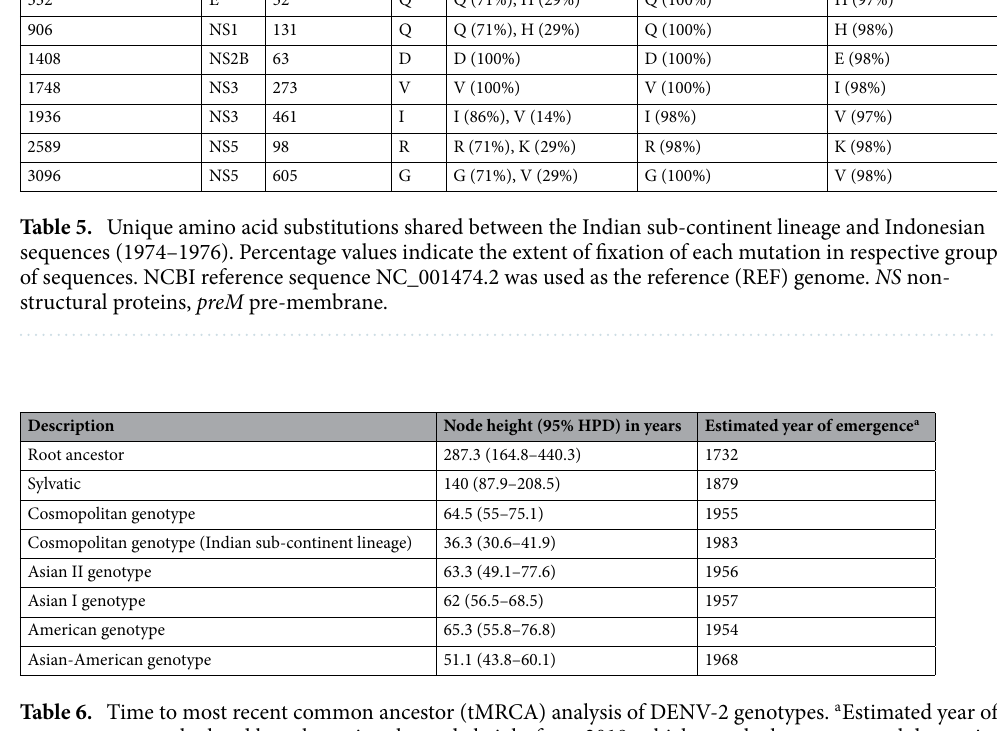
Table 6. Time to most recent common ancestor (tMRCA) analysis of DENV-2 genotypes. a Estimated year of emergence was calculated by subtracting the node height from 2019, which was the latest temporal data point in the analysis. The tMRCA data was obtained from the complete genome based maximum clade credibility tree. HPD Highest posterior